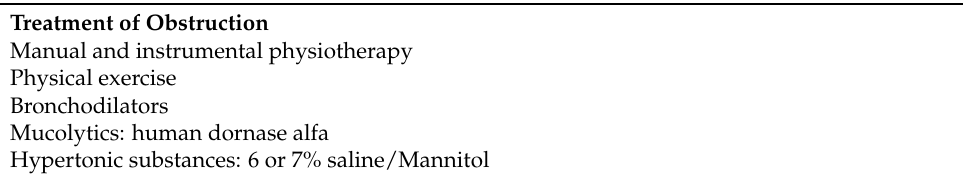
Table 1. Treatment of the respiratory condition in CF patients (pulmonary symptomatic